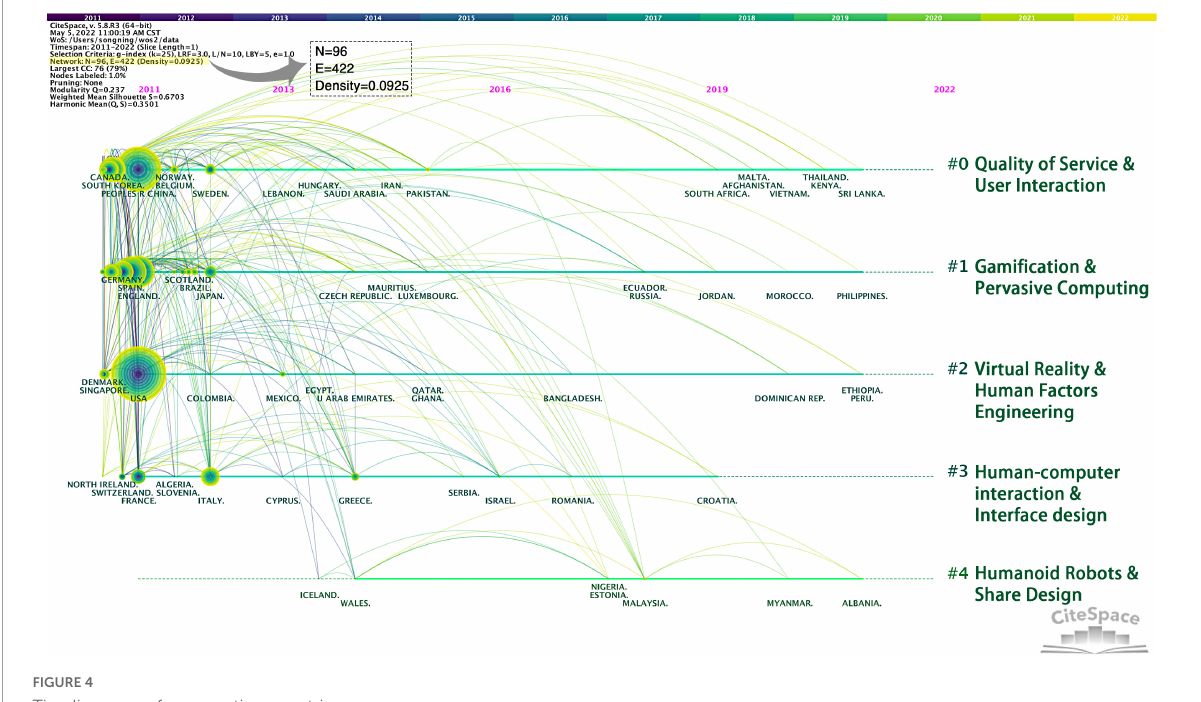
FIGURE4 Timeline map of cooperative